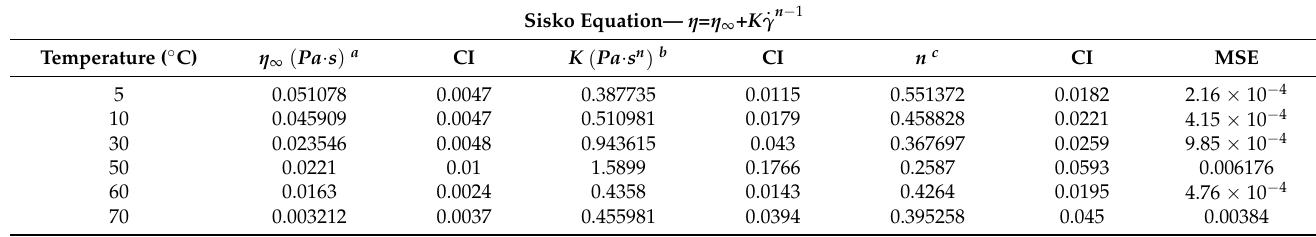
Table A6. Fitting parameters ( η ∞ , K , n ), confidence intervals (CI), and mean square error (MSE) values as a function of temperature obtained from the modified Ostwald–de Waele model by Sisko, or Sisko equation [47], modeling the 0.1 to 1000 s − 1 shear rate range for flow curve data sets of ink suspensions with a 0.80 wt% HRCM load.